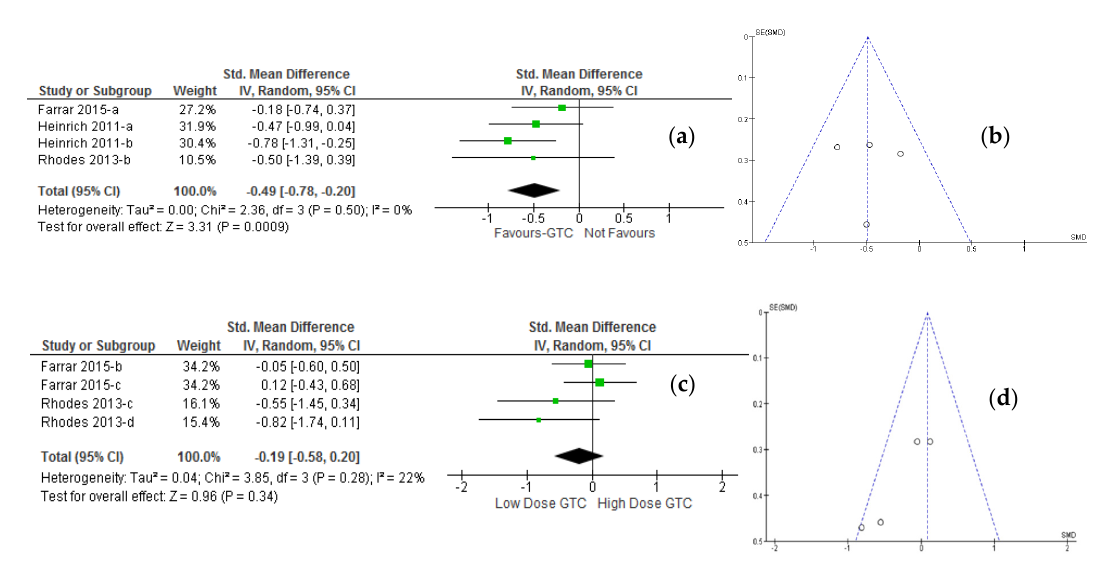
Figure 4. Meta-analysis of the effect of the oral green tea catechin supplementation on ultraviolet radiation-induced erythema response at varying UV-irradiation challenges. ( a ) Forest plot of randomized controlled studies in healthy adults comparing the effect of before (pre − ) and after (post-) oral green tea catechin interventions at low-intensity MED challenge ranges between 1.25–1.30; ( b ) Funnel plot of representative oral green tea catechin supplementation studies. ( c ) Forest plot of randomized controlled studies in healthy adults comparing the effect of before (pre − ) and after (post-) oral green tea catechin interventions at high-intensity MED challenge ≥ 1.50; ( d ) Funnel plot of representative oral green tea catechin supplementation studies. Keys: As illustrated in Figure 3.